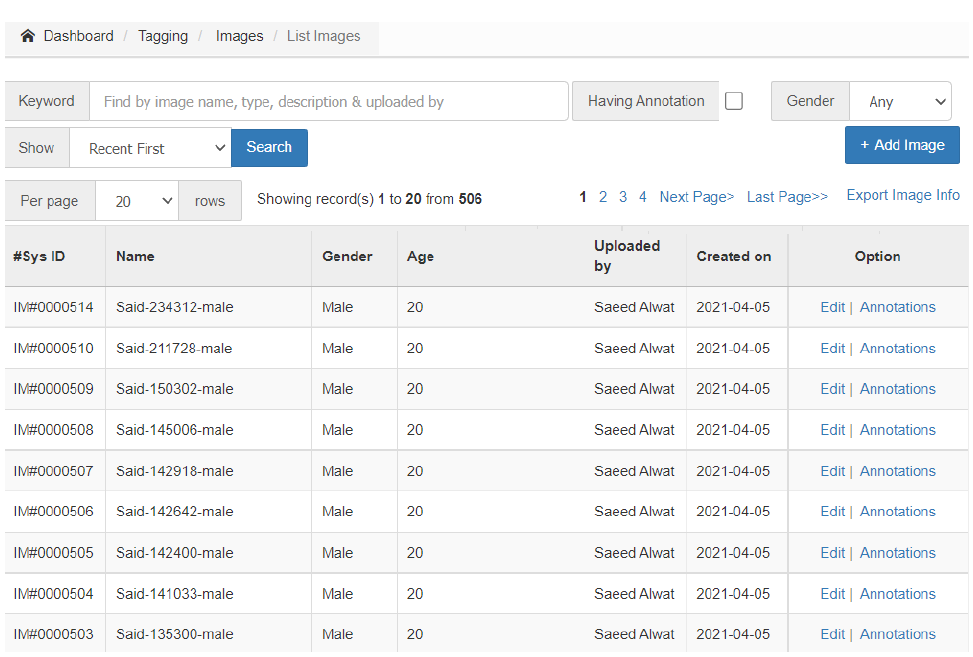
Figure 3. The first landing page after login to show the list of